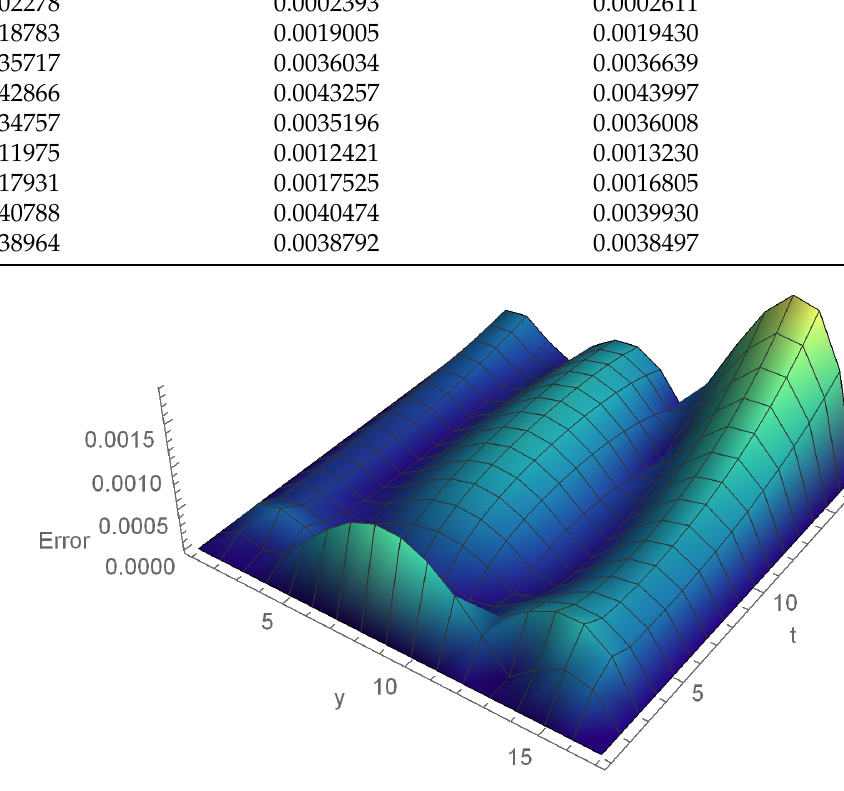
Figure 1 . Error graph of Example 1 at γ = 0.5 and α = 0.05.